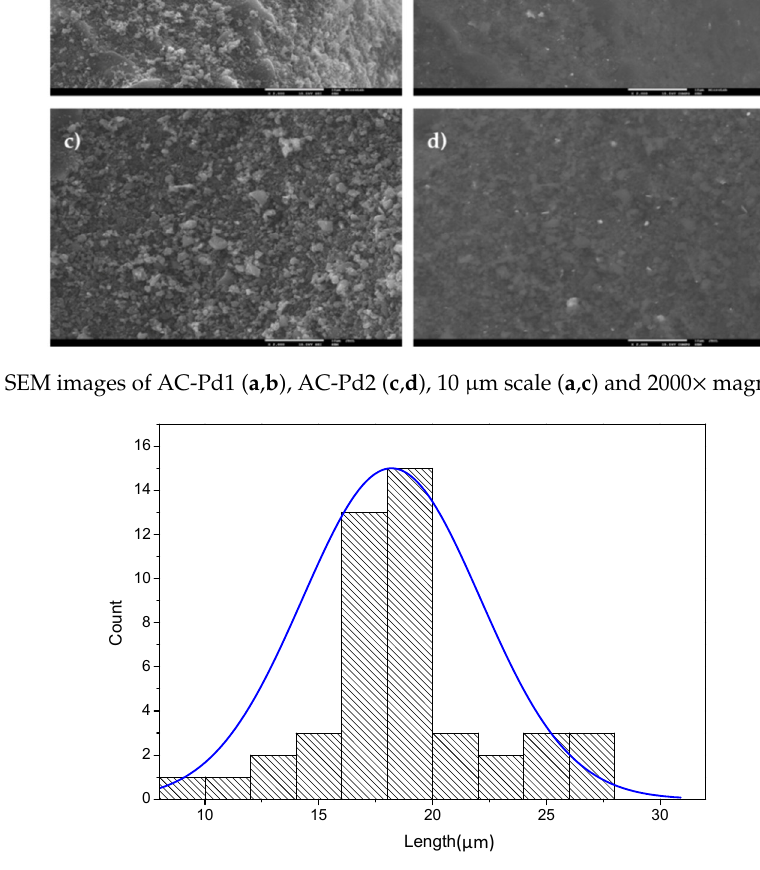
Figure 3. Particle size distribution in the AC-Pd2 sample.